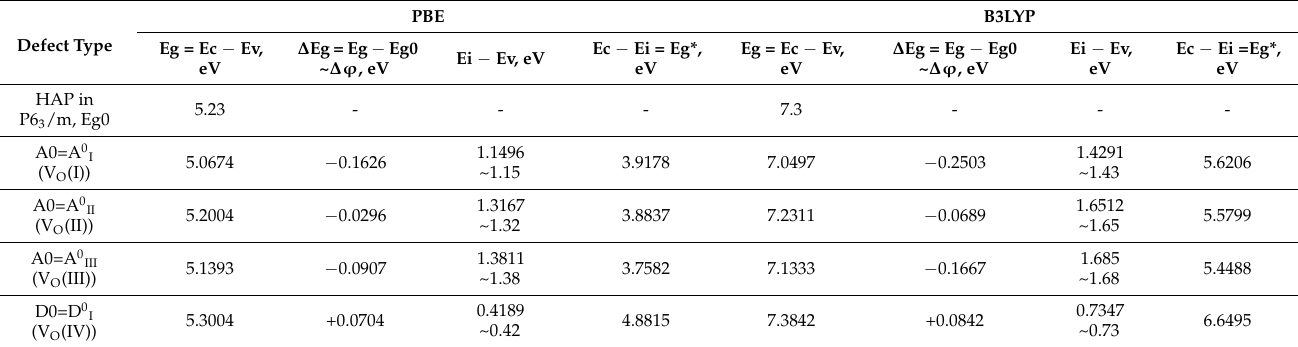
Table 5. Data for O vacancy from OH and PO 4 in different position and symmetry (errors ± 0.05 eV).